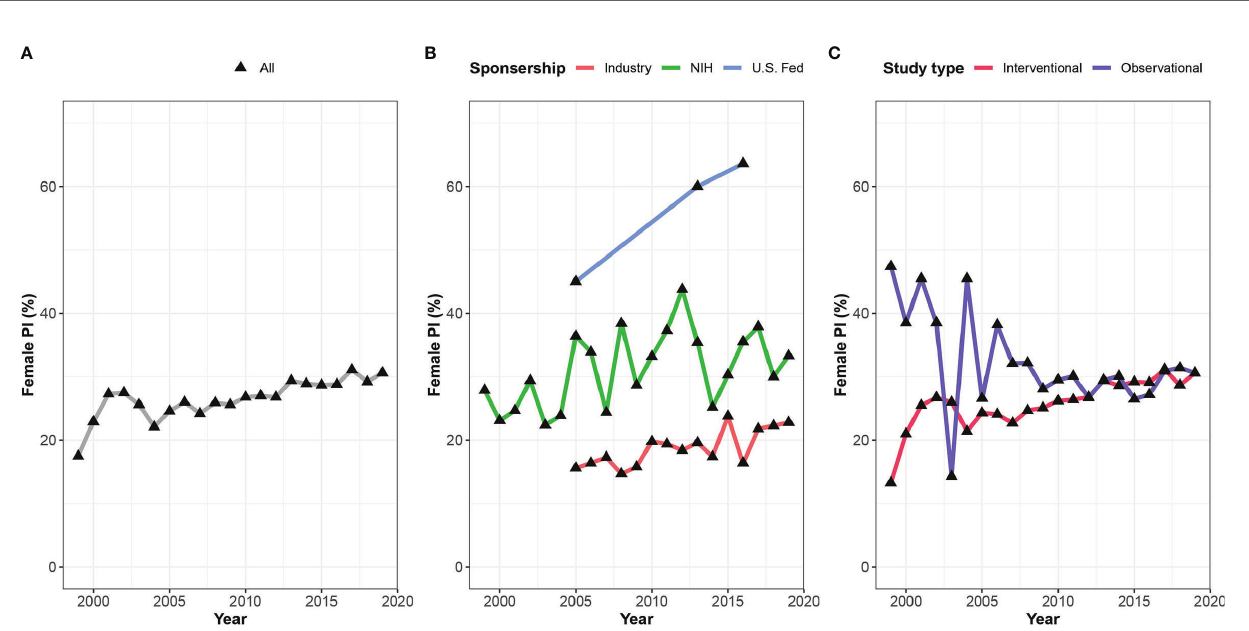
FIGURE 4 | Gender gap among lead investigators in oncology clinical trials over time. Shown are proportions of women leading oncology trials between 1999 and 2019 for (A) all included studies, (B) studies strati fi ed by sponsorship, and (C) type of